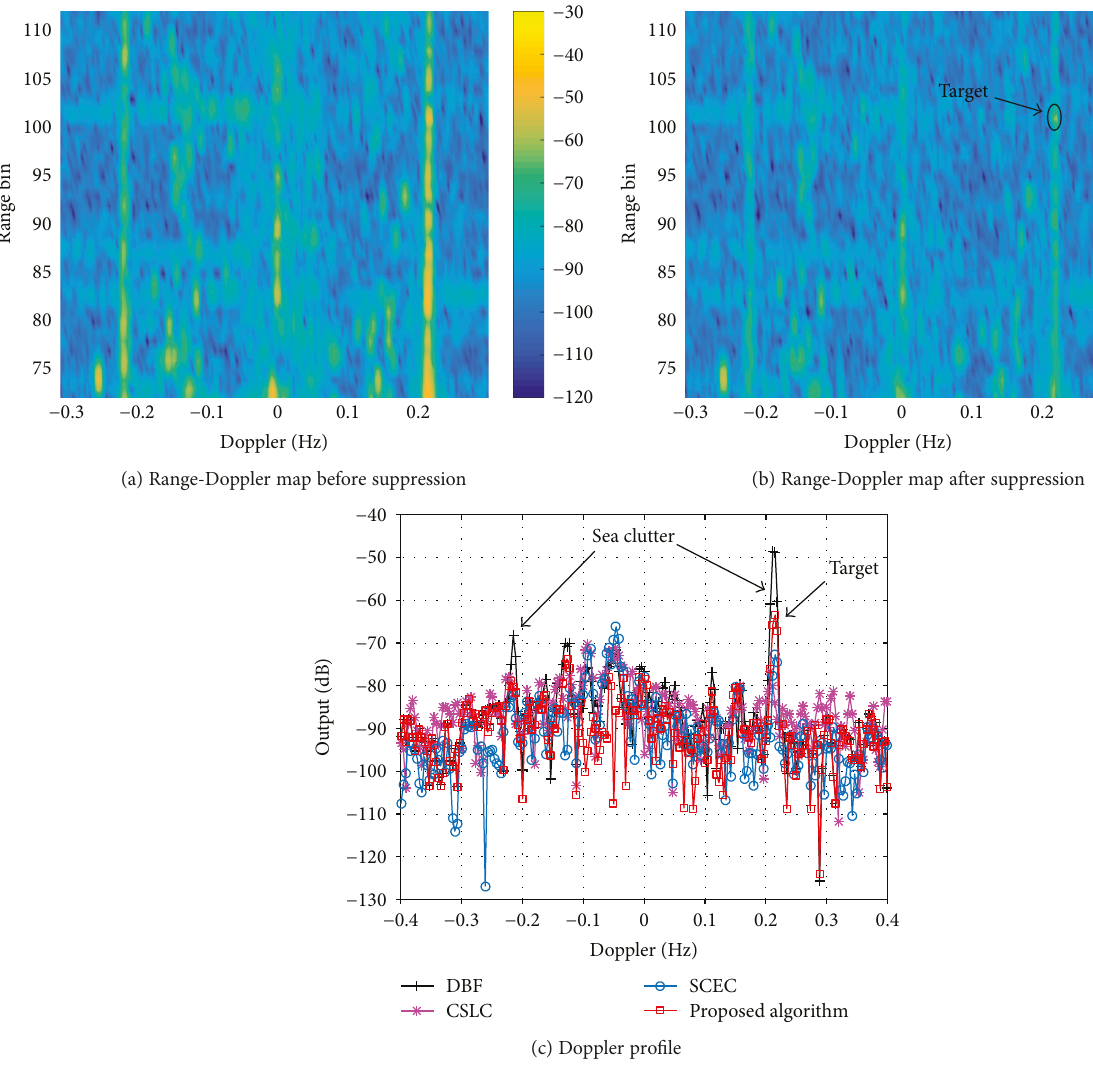
Figure 9: Comparison results for sea clutter cancellation. Table 3: Injected target